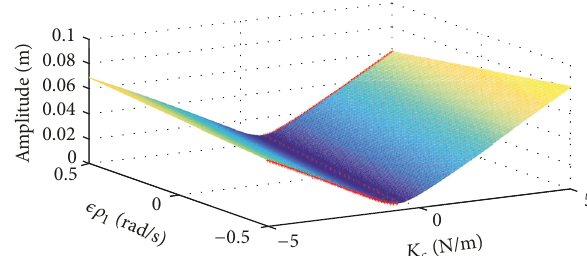
Figure 11: Parameterized FRF of the primary system in terms of the PZT actuator stiffness 𝑘 𝑐 ∈ [−5,5]